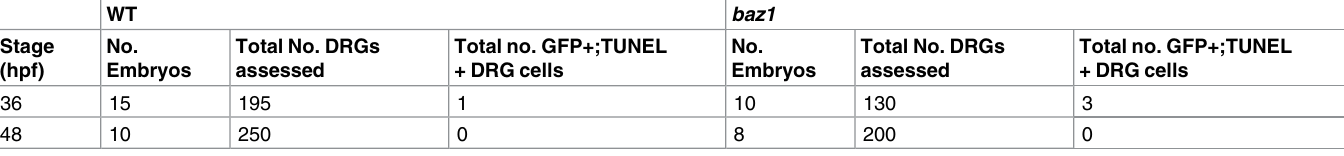
Table shows number of embryos scored, number of DRGs assessed per embryo and total number of TUNEL+ DRG cells in all embryos scored.